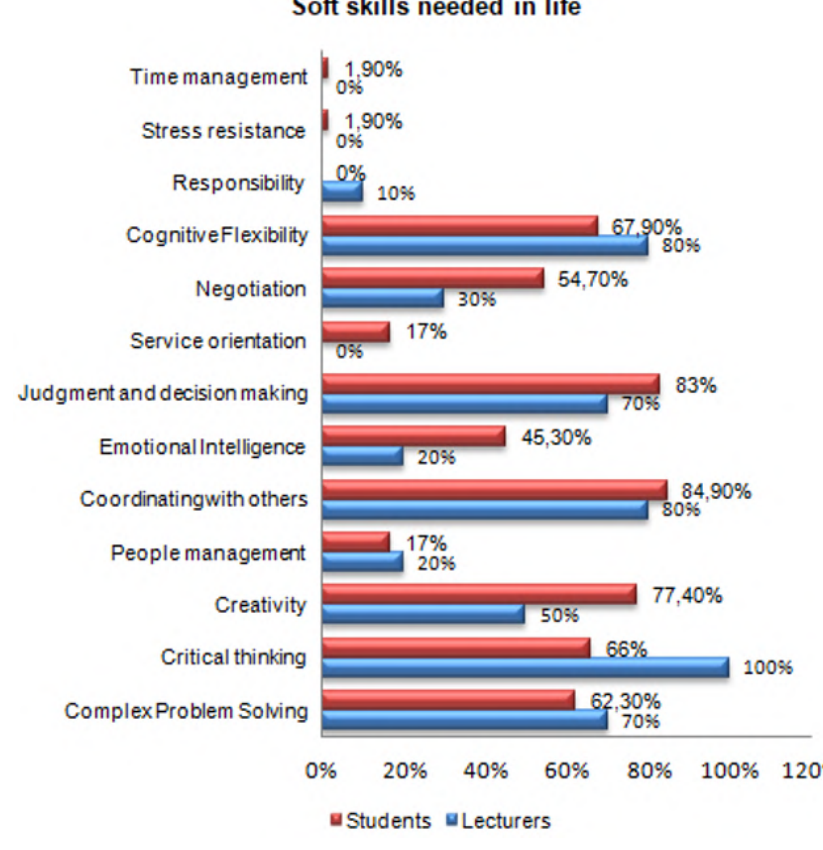
Figure 90: Presentation of paper